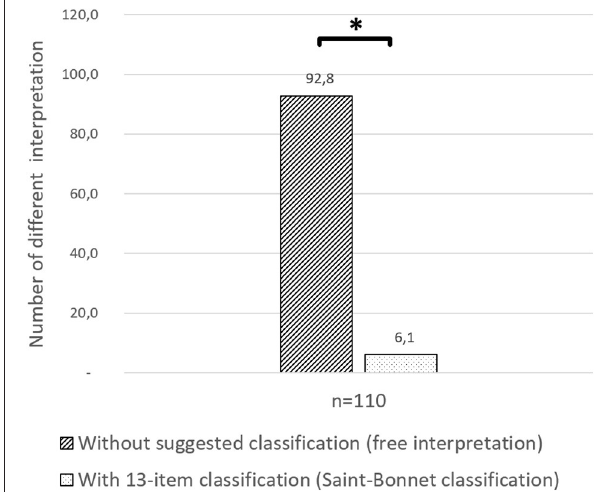
FIGURE 2 | Heterogeneity comparison. Number of different responses of the 20 Doppler waveforms among 110 participants with free interpretation and with suggested Saint-Bonnet classification. * p <